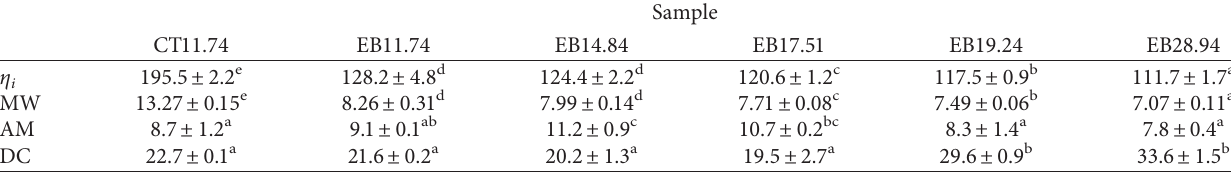
Table 1: Intrinsic viscosity, apparent amylose content, and molecular weight.